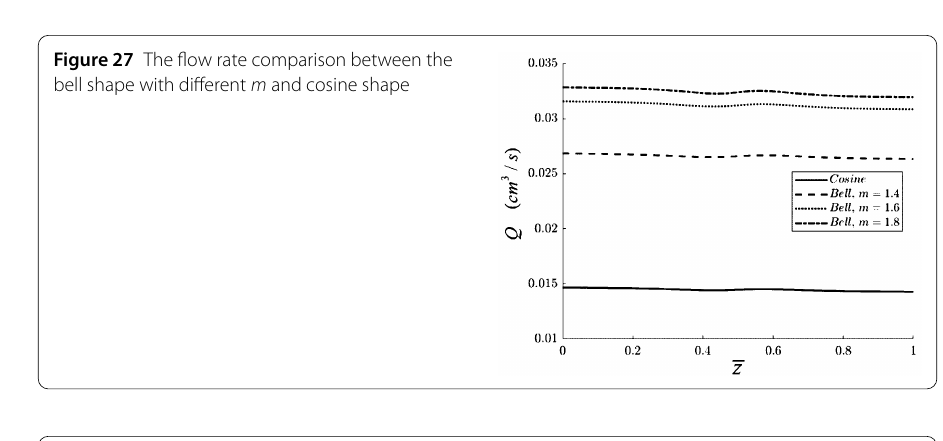
Figure 28 Variation of resistance to the flow with axial distance for different stenosis heights in bell shape and the combined shape of bell and cosine